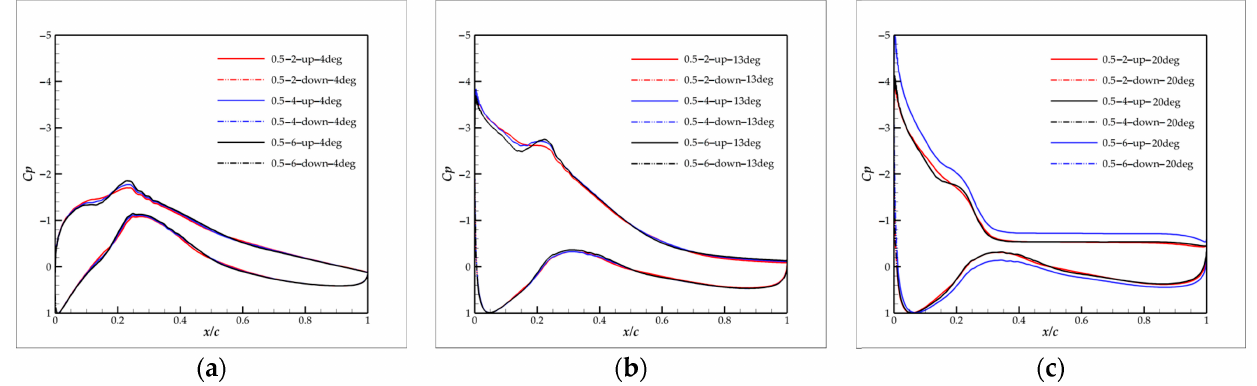
Figure 19. Pressure distribution with 50% repair width: ( a ) α = 4 ◦ ; ( b ) α = 13 ◦ ; ( c ) α = 20 ◦